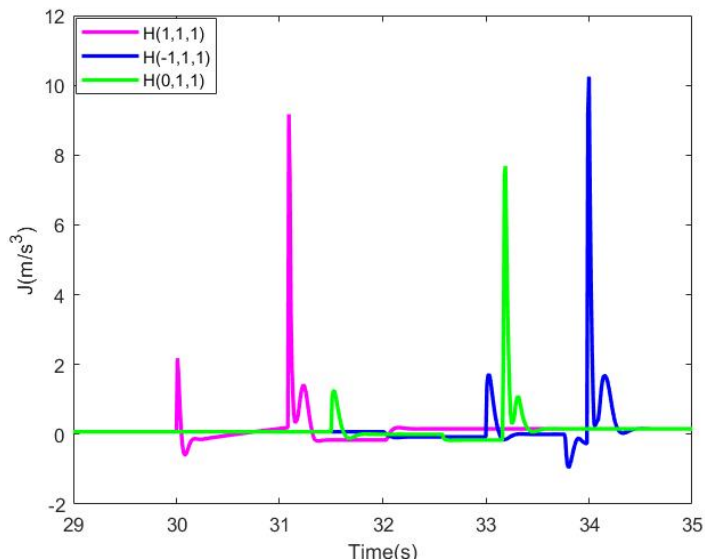
Figure 16. The jerk in different control strategies ( H = (x,1,1)).